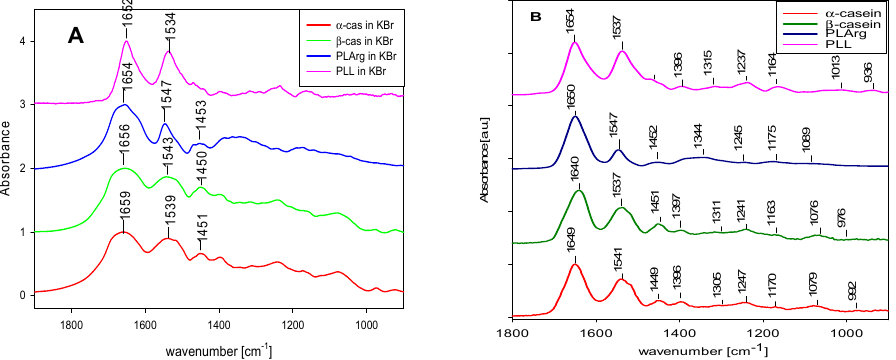
Table 1. Sequences of aminoacids representing fragments of casein chain used in the molecular dynamics simulations.